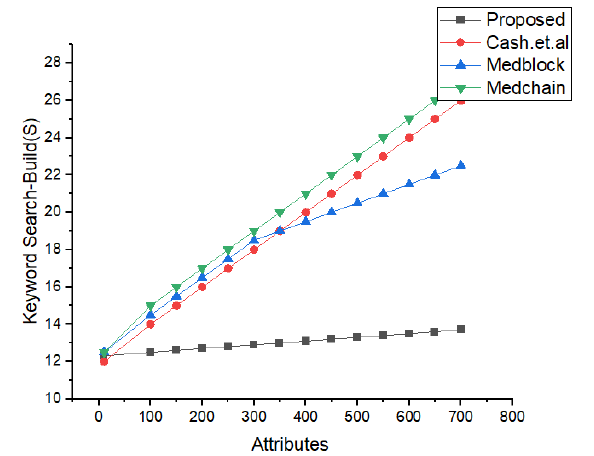
Figure 18. Comparative Analysis of Search time vs.